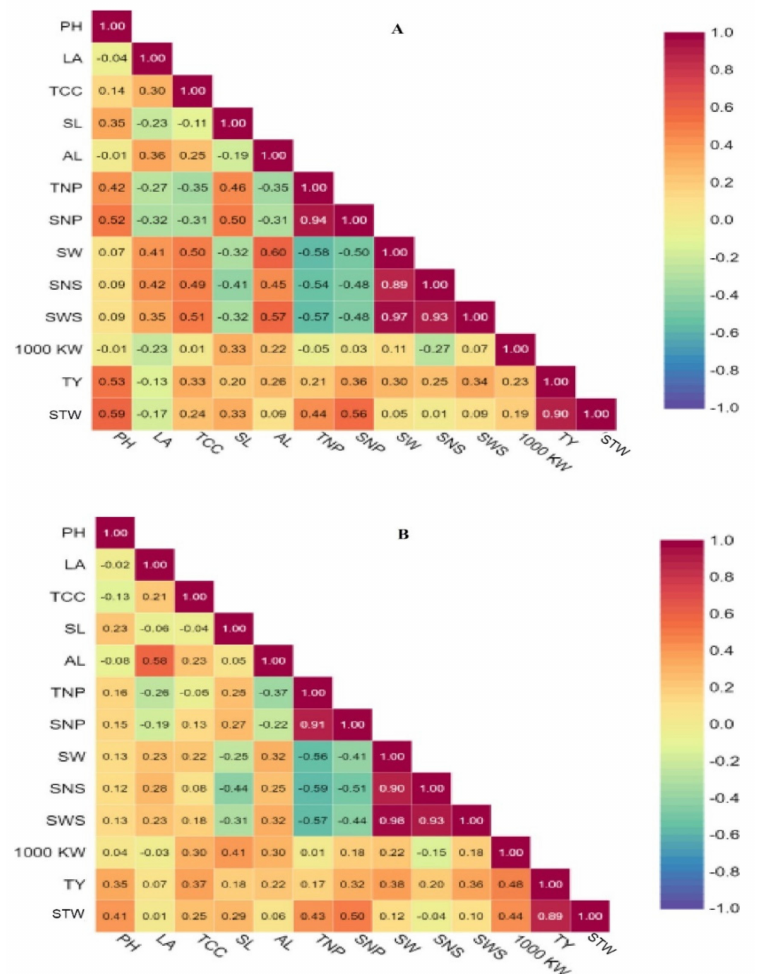
Figure 3. Pearson correlation (r) between 13 morphological parameters in the untreated ( A ) and treated ( B ) conditions with moringa organ extract. PH: plant height, LA: leaf area, TCC: total chlorophyll content, TNP: number of the tillers per plant, SNP: number of the spikes per plant, SL: spike length, AL: awan length, SW: spike weight, SNS: number of seeds per spike, SWS: seed weight per spike, 1000-KW: 1000-kernel weight, TY: total yield per plot, STW: straw weight per